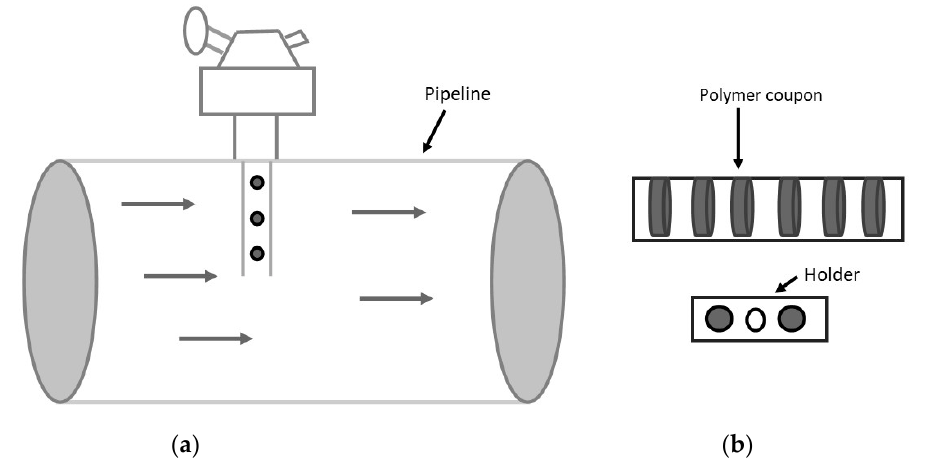
Figure 9. ( a ) Polymer coupon in the pipeline, ( b ) coupon and holder.